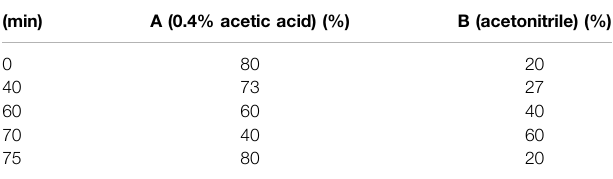
TABLE 1 | Mobile phase condition of chromatographic